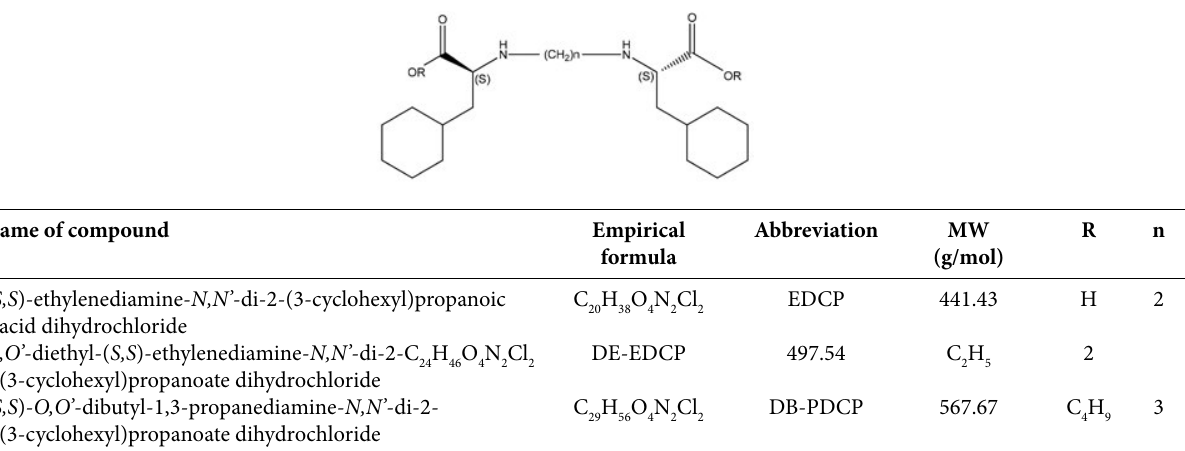
Table 1: Structure of EDCP, DE-EDCP, and the internal standard DB-PDCP